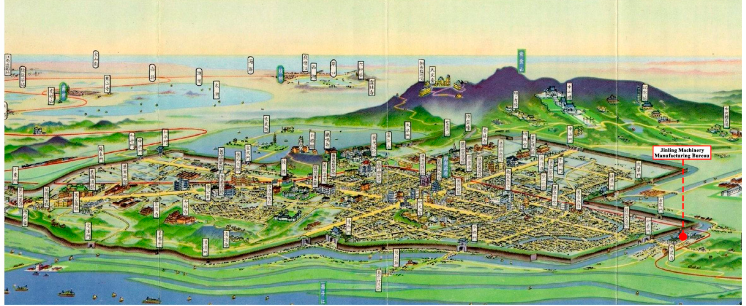
Figure 4. The location of Jinling Machinery Manufacturing Bureau in 1890s. Modified from [37].